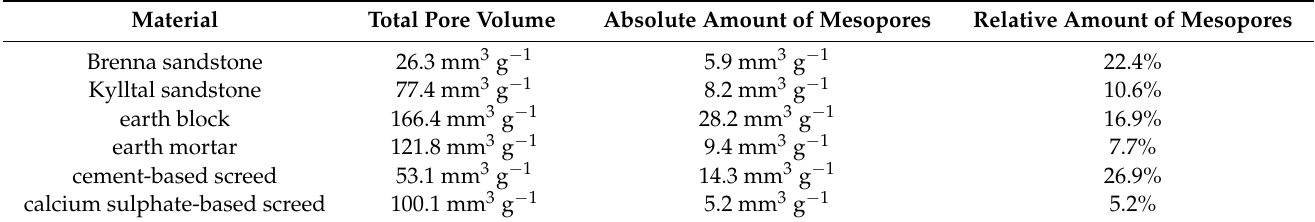
Table 3. Amount of mesopores within the